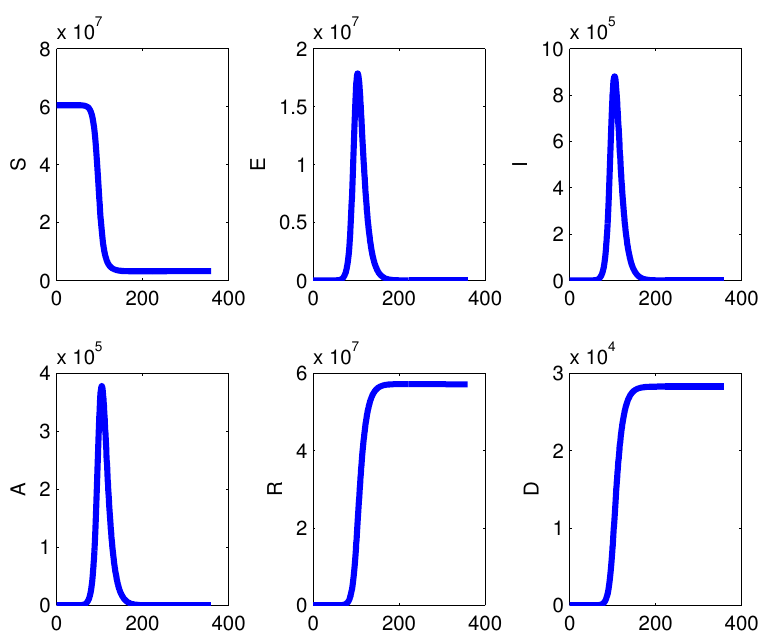
Figure 25. The epidemic’s effect on the population in the absence of measures for β I = 10 − 7 , over a period of one year. Left to right and top to bottom, the total population sizes: S , E , I , A , R and D , the disease-related deceased